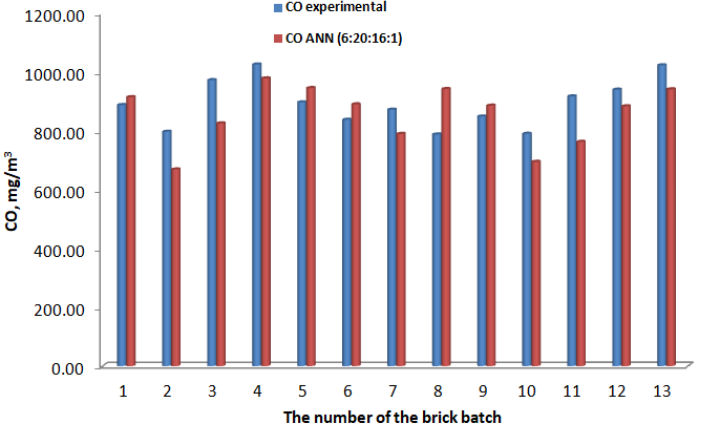
The results obtained with the ANN(6:20:16:1) model in the validation stage are shown in Figure 2.